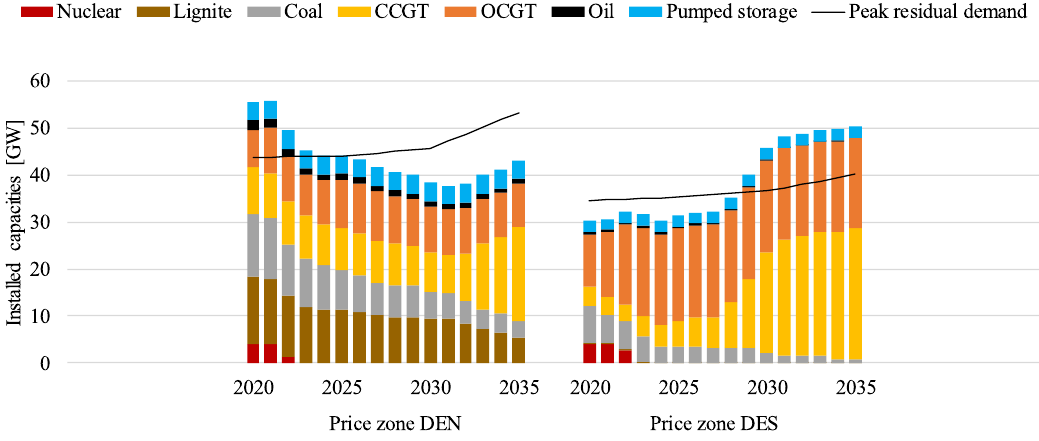
Figure 7. Simulated development of the conventional power plant capacities in the two German price zones DEN and DES in the SPLIT case. Abbreviations: CCGT—combined cycle gas turbine, OCGT—open cycle gas